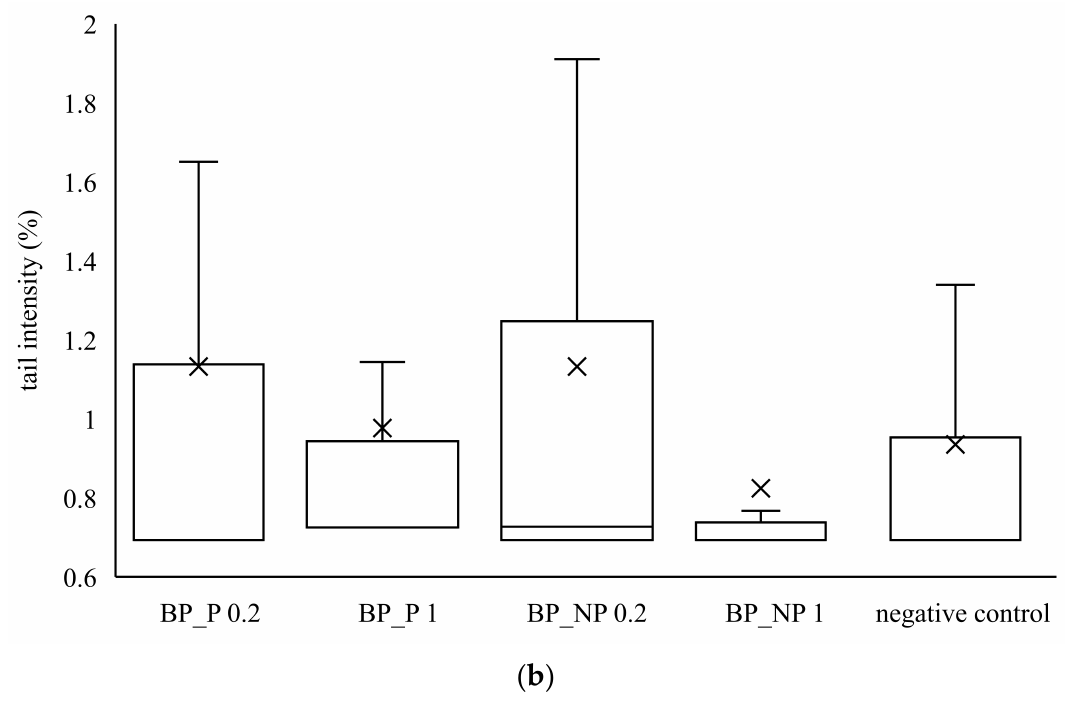
Figure 3. Genotoxic effect of banana peel extract on ( a ) CaCo2 cells and ( b ) HepG2 cells. A box and whisker plot summary of a set of tail intensity data obtained in 100 comets. X represents the mean value of tail intensity, the bottom line is the minimum, the middle line represents the median value of tail intensity, and the area above the median line is the third quartile of tail intensity data. The upper whisker is the maximum value measured by the comet assay. BP_P-banana peel extract with polysaccharides; BP_NP-banana peel extract without polysaccharides, concentrations 0.2 and 1 mg mL − 1 .